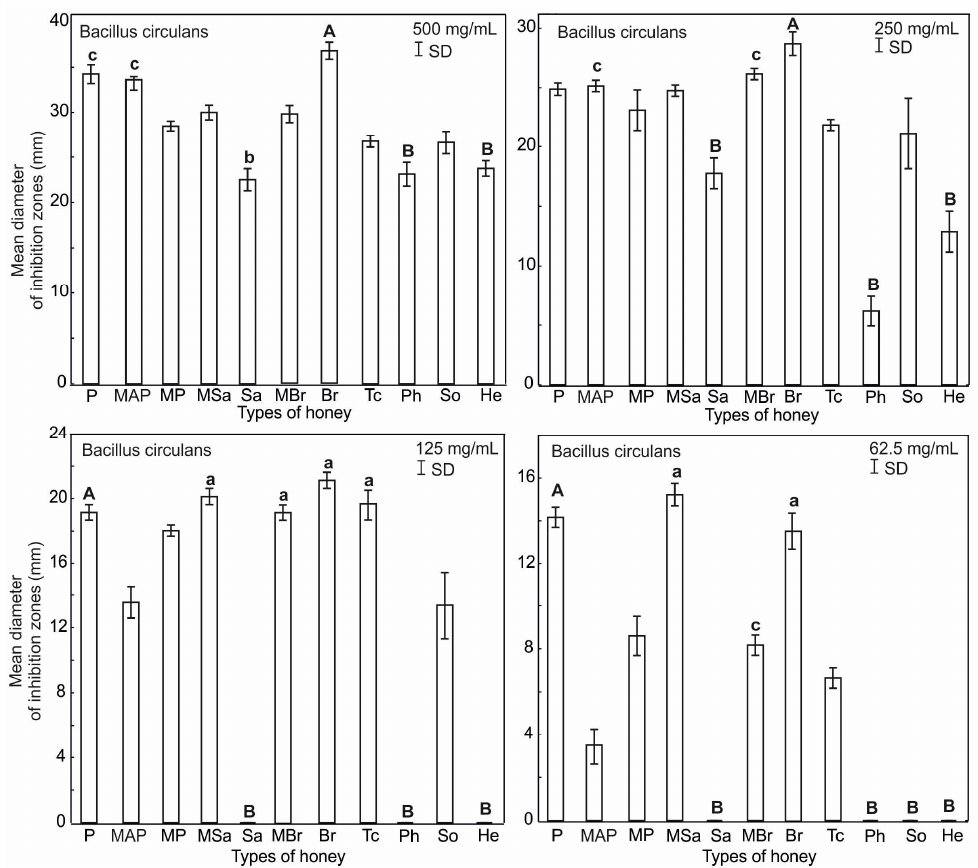
Figure 3. Results of the ANOVA Kruskal–Wallis H test for the mean inhibitory activity of all the tested honeys types and their concentrations against B. circulans . Statistical differences are indicated by different letters and their significance at p ≤ 0.001 with capital letters (A), p ≤ 0.05 with small letters (a). Upper and lower case letters above the bars indicate different levels of statistical significance.